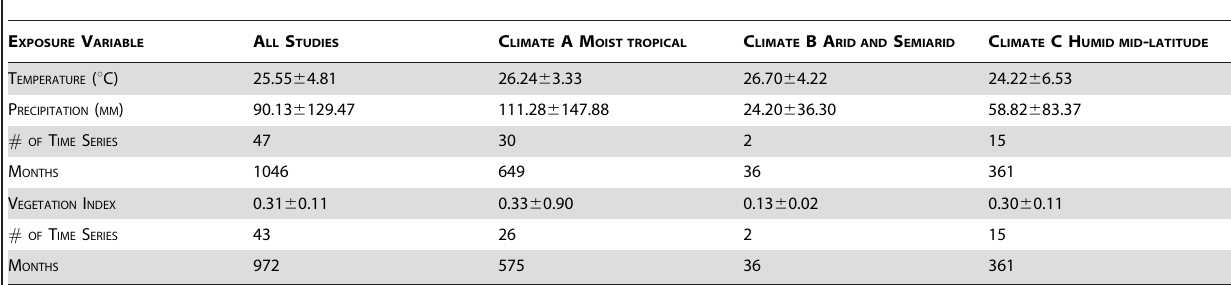
Table 2. Descriptive characteristics for all studies and by climate category.